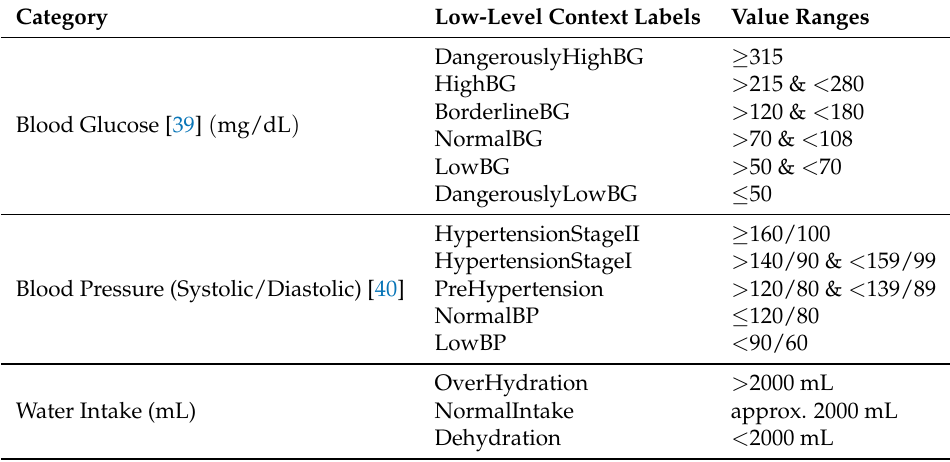
Table 2. Low-level Context labels assigned based on ranges of